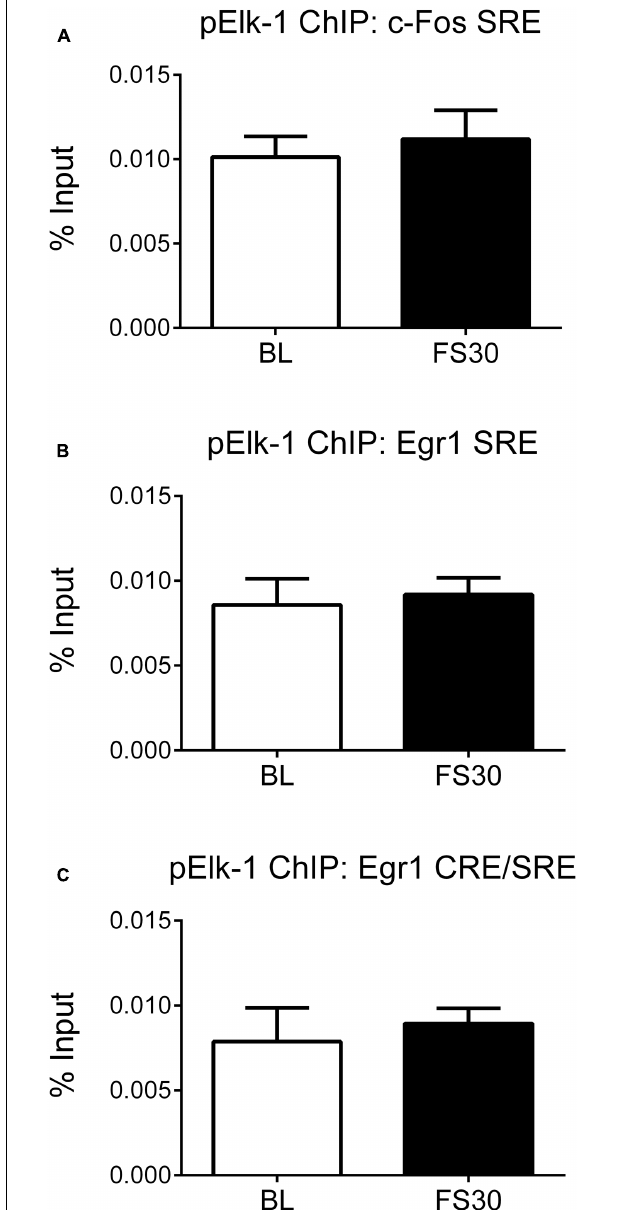
FIGURE 4 | pElk-1 binding at SREs in the promoter regions of c-Fos and Egr-1 . Rats were killed either under baseline conditions or 30 min after the start of FS (15 min in 25 ◦ C water). Chromatin immuno-precipitation was carried out on whole hippocampal tissue, using an antibody against pElk-1. Primers for qPCR were designed to cover the SREs in the c-Fos and Egr-1 promoters. In addition, the primers, which cover the CREs in the Erg-1 promoter, also cover two SREs, therefore these primers were also used in this case. Due to low levels of DNA recovered from the ChIP, 2 µ l of bound and input were loaded into the PCR mix and the % input method was used to analyze results (see section “Materials and Methods”). The graphs show % input values for pElk-1 at (A) the SRE region of the c-Fos promoter, (B) the distal SRE region of the Egr-1 promoter, (C) the more proximal SRE/CRE region of the Egr-1 promoter (mean ± SEM, n = 3–4). Statistical analysis: Student’s unpaired t -test; (A) t = 0.53, p = 0.6219, (B) t = 0.30, p = 0.7768, (C) t = 0.44, p =